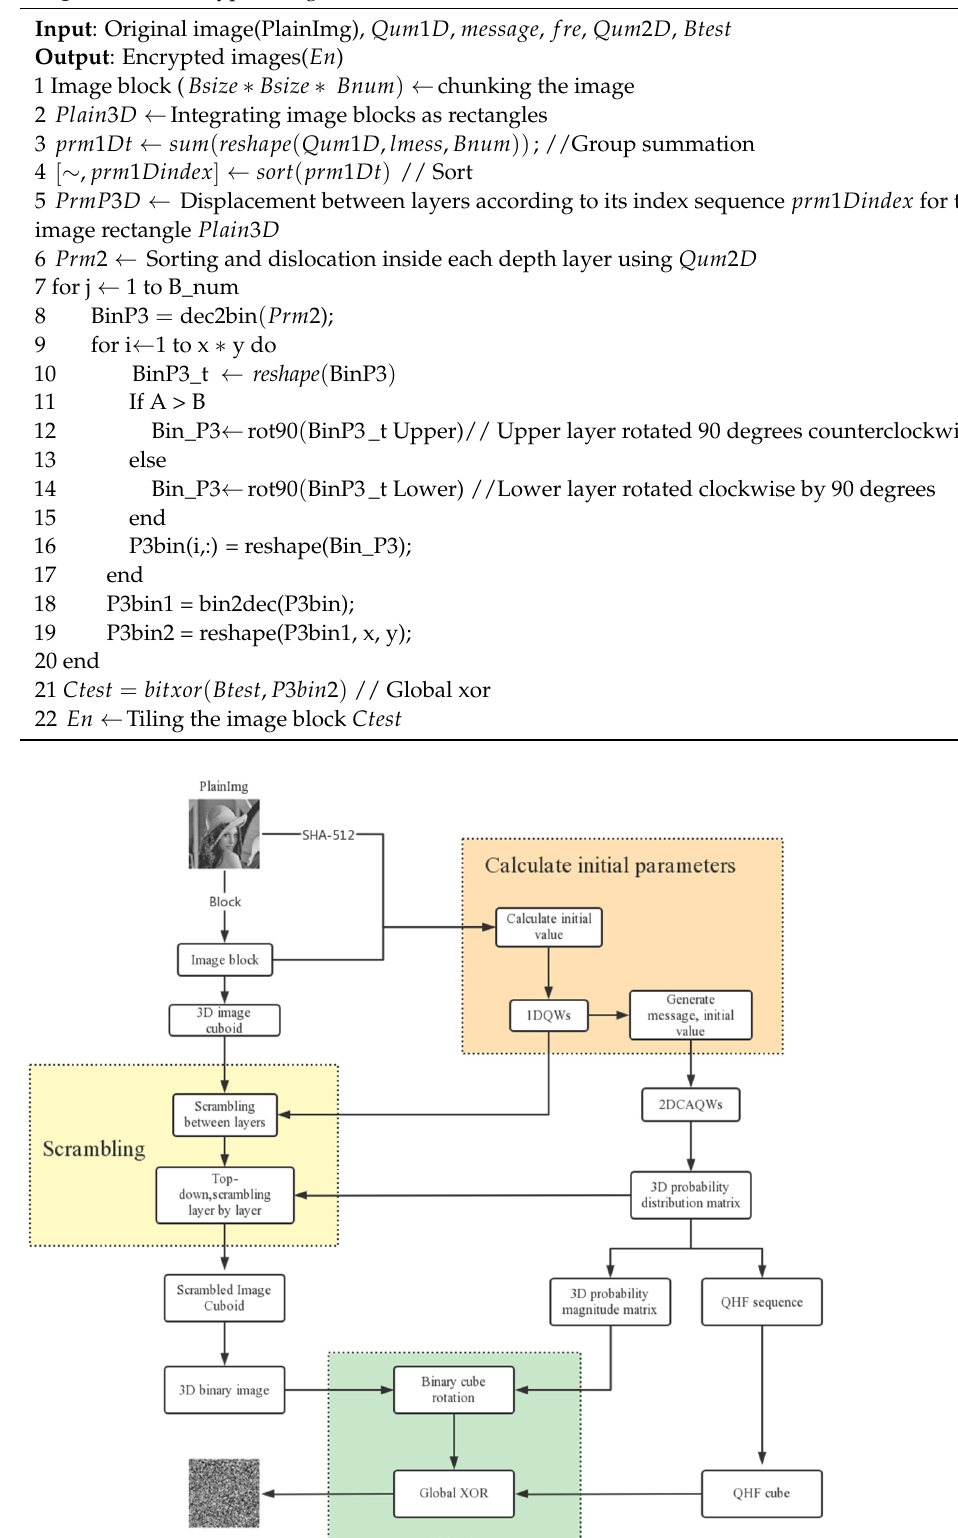
Algorithm 2. Encryption algorithms.